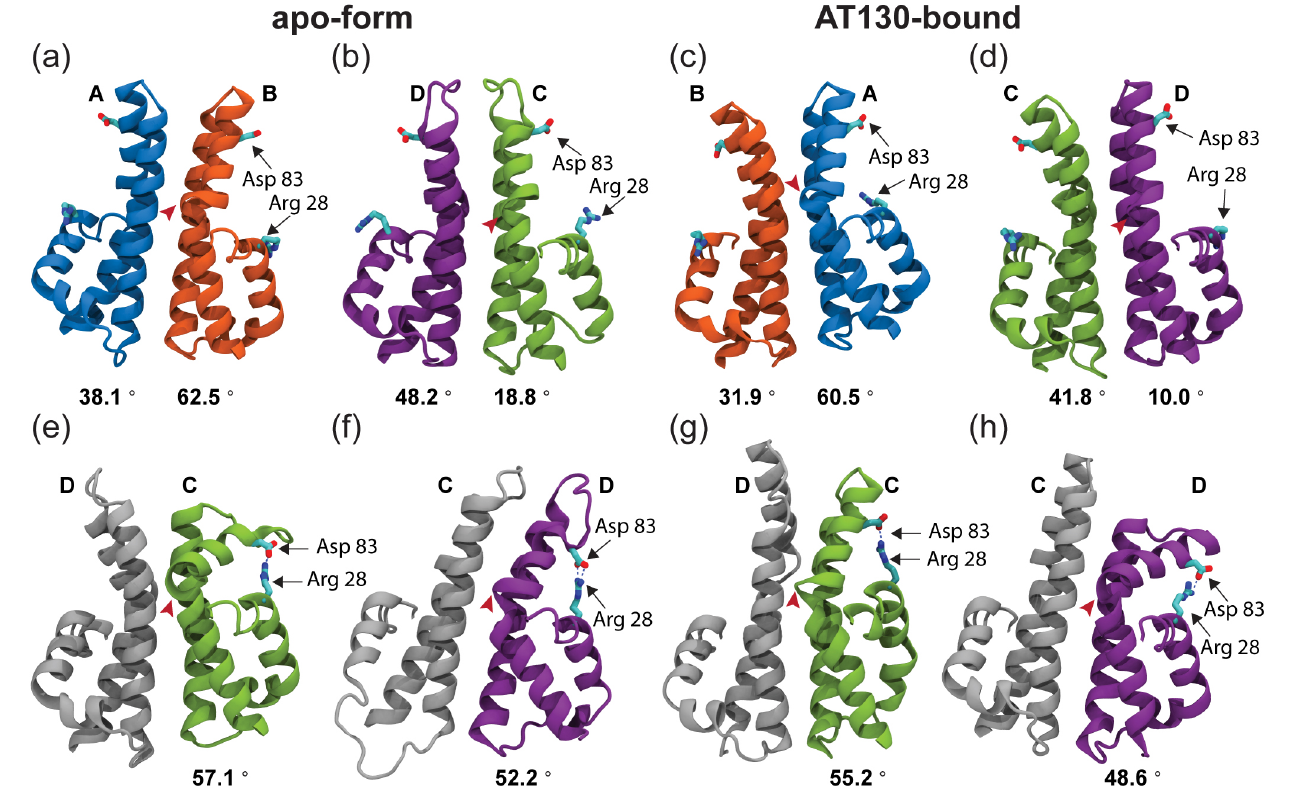
Figure 6. Notable conformations of capsid-incorporated dimers. ( a , b ) Representative structures for apo-form AB and CD dimers. ( c , d ) Representative structures for AT130-bound AB and CD dimers. Quasi-equivalent chains A, B, C, and D are colored blue, orange, green, and purple, respectively. Arg28 and Asp83, which can form a rare salt bridge, are labeled. Apex of the dimer hinge (Val93) is denoted by a red arrow and measurement of curvature at the apex is given beneath. ( e – h ) Structures for apo-form and AT130-bound CD dimers illustrating conformations that allow the Arg28–Asp83 salt bridge, enabling direct contact between the spike and fulcrum. All structures are aligned based on the dimer chassis. Conformations with large hinge angle and intact salt bridge within a half-dimer exhibit an open spike tip and disrupted intradimer interface. This state was observed most often for the AT130-bound D chain (2.1% versus < 0.4% of conformers, see Figure